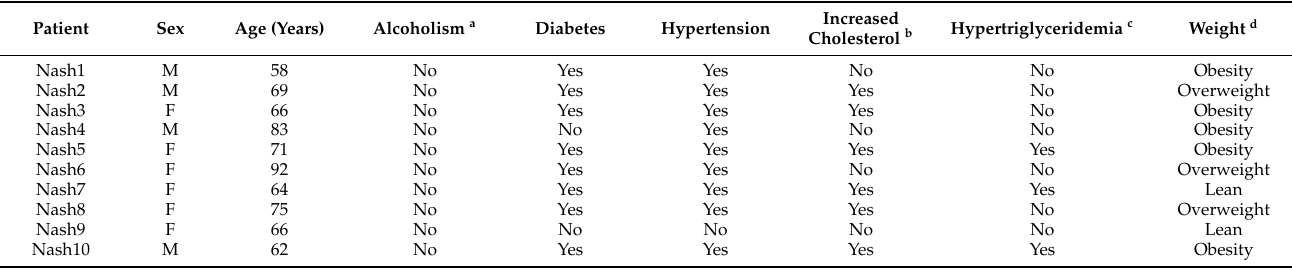
Table 1. Patients’ and controls’